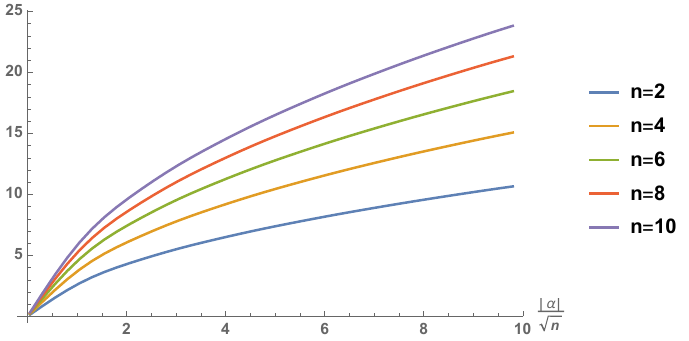
Figure 3. Complexity n labels the bosonic excitation b y twenty times of the bosonic excitation n for the